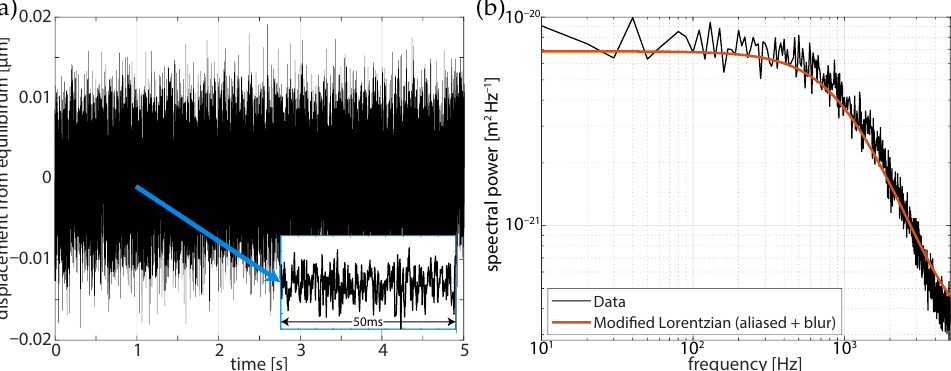
Figure 4. ( a ) Position trace of a 5 s calibration experiment (inset: 50 ms of data at t = 1s) and ( b ) corresponding power spectrum for 2µm diameter polystyrene bead, the equilibrium fit yields a stiffness estimate of 118pNµm − 1 ( ω c = 6942s − 1 ) for the optical